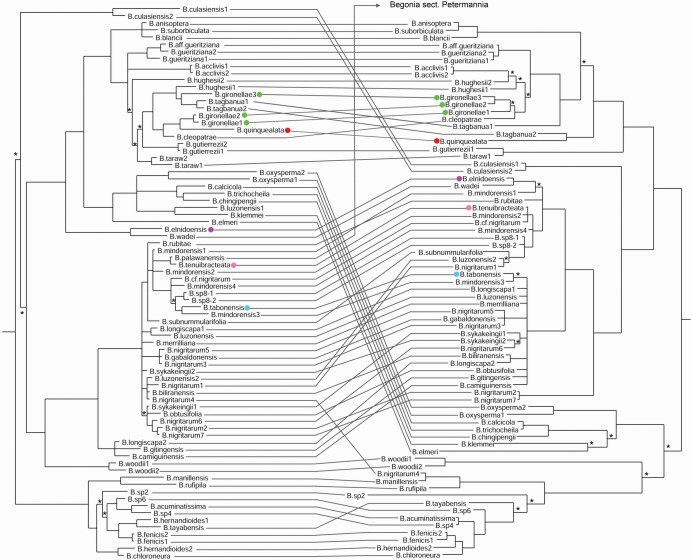
Tanglegram comparing nuclear and plastid phylogenies of Begonia sect. Baryandra.Based on Bayesian analyses of chloroplast data (left) and nrDNA ITS data (right); trees are 50% majority rule consensus trees; asterisks mark clades with PP< 0.95; outgroups not shown; scale bars show number of substations per site in the alignment. The species described as new are highlighted by coloured circles.